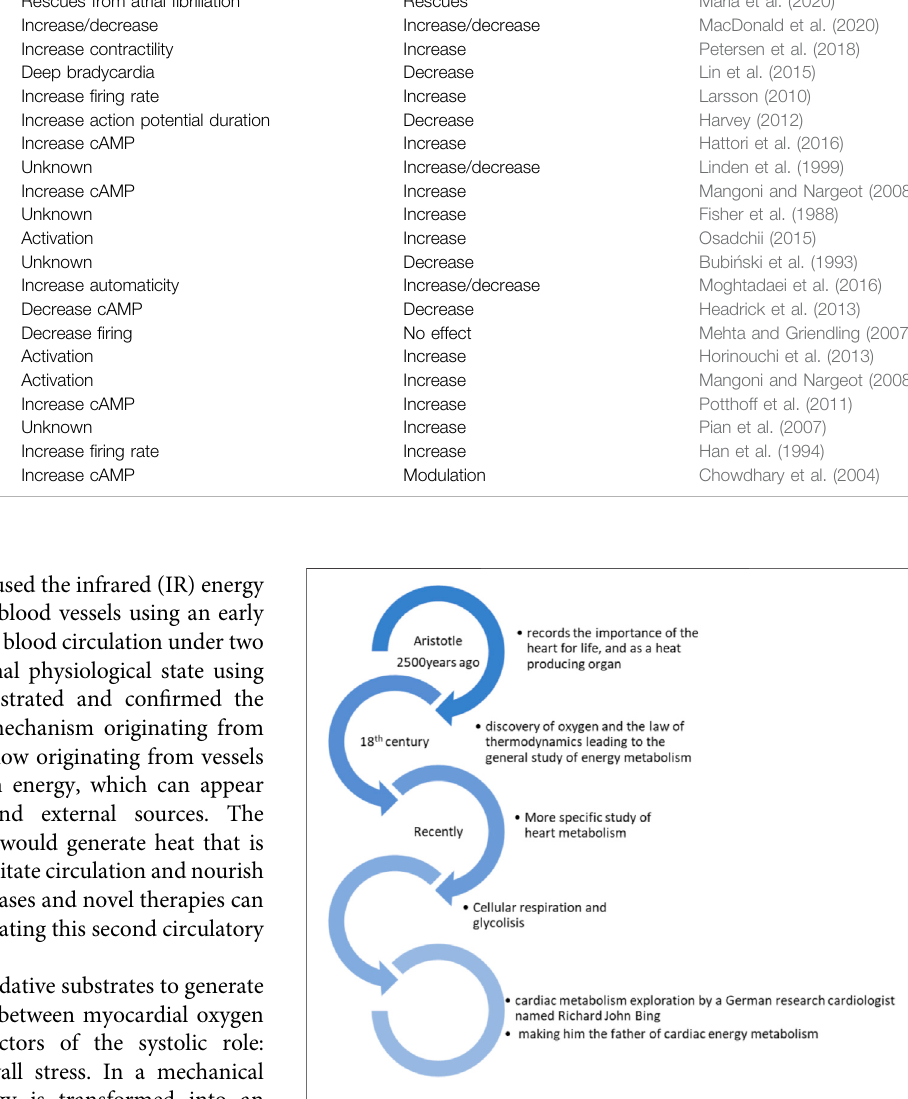
FIGURE 2 | The history of cardiac